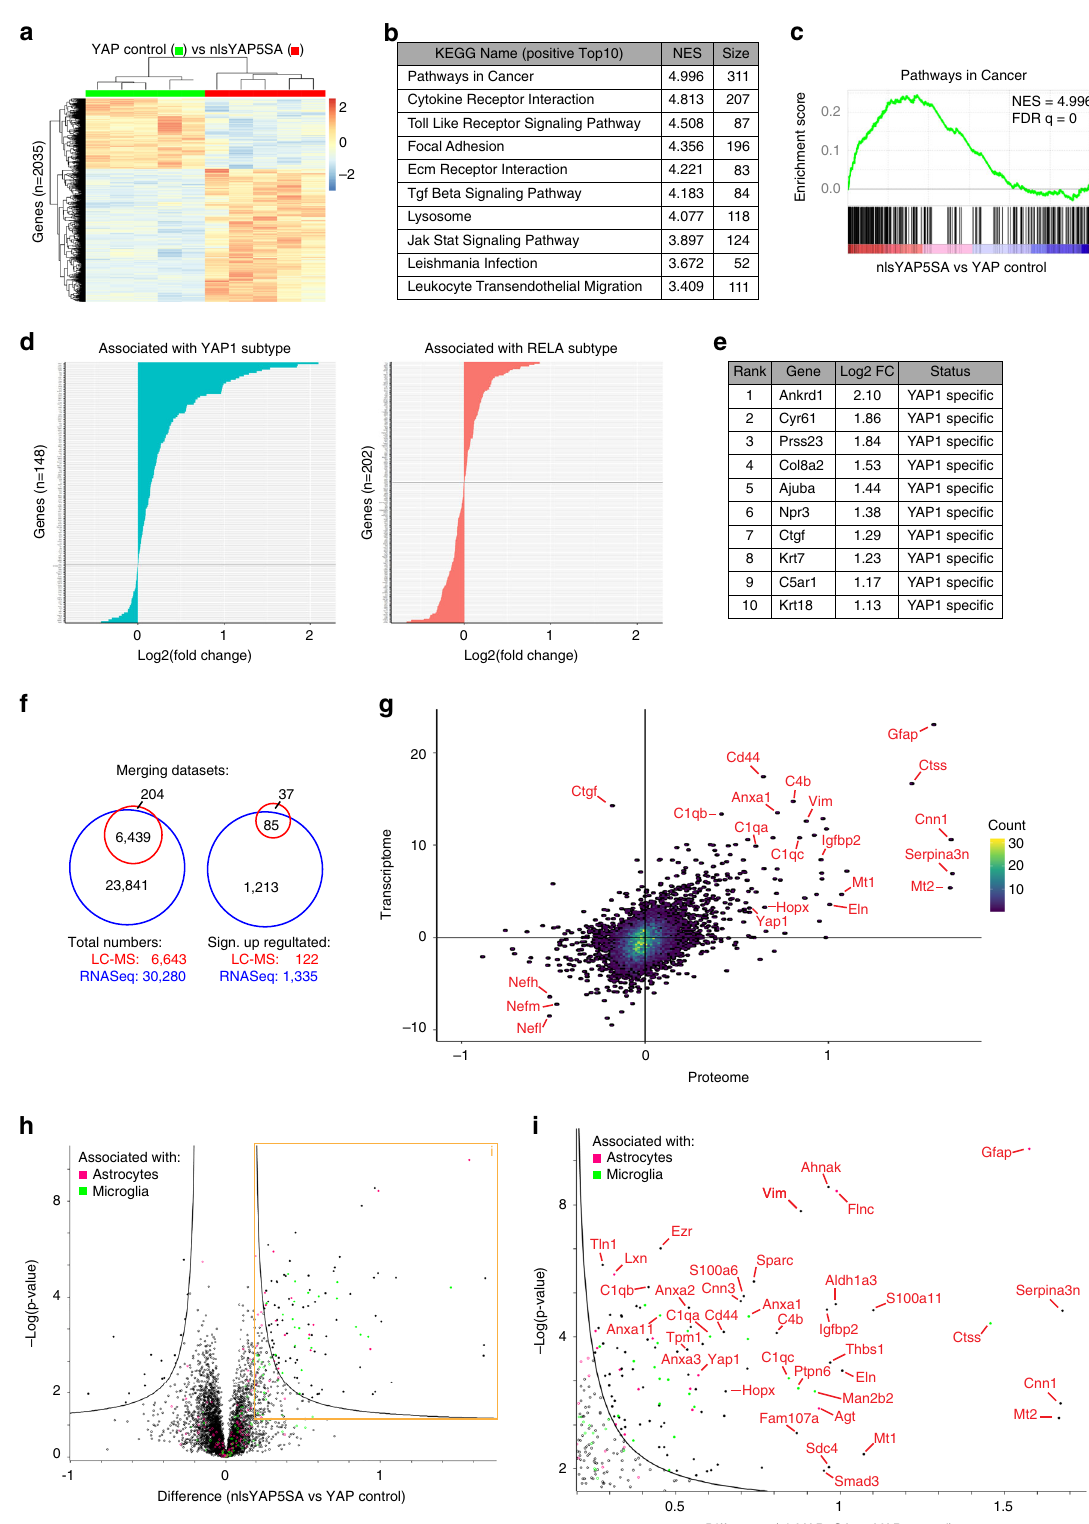
differential expression in nlsYAP5SA and control. We then applied gene enrichment analysis (GSEA) choosing the Kyoto Encyclopaedia of Genes and Genomes (KEGG) database to ranked list. Among the top 10 upregulated gene sets in